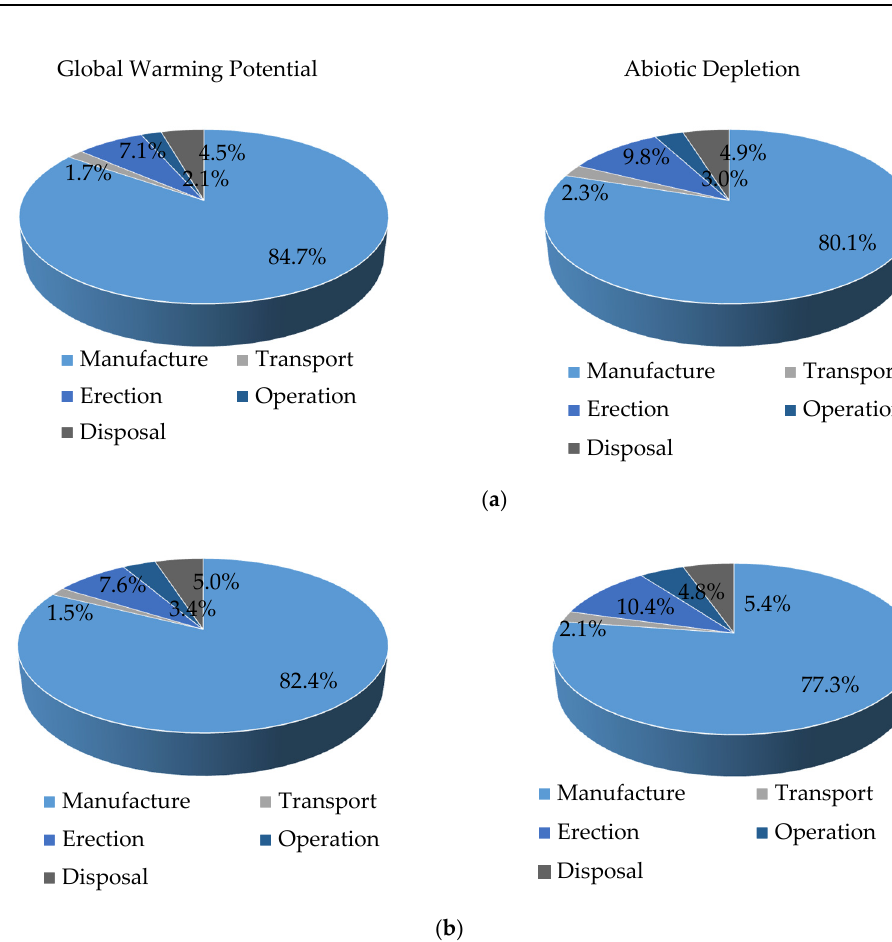
Figure 6. Contribution of each life cycle stage. ( a ) 6-legged, ( b ) 4-legged.